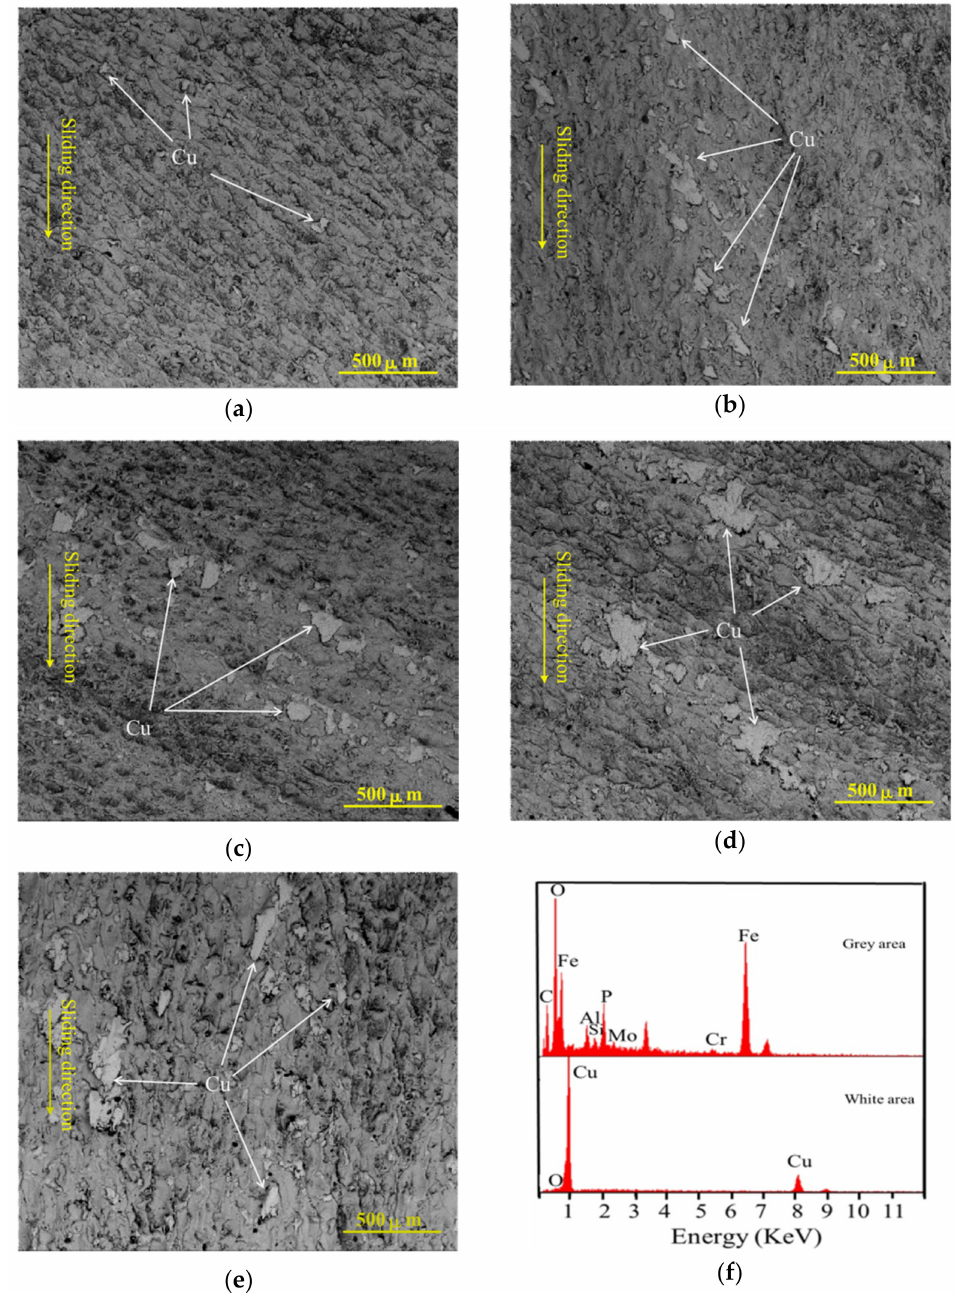
Figure 5. SEM images on the worn surfaces of 38CrMoAlA steel discs working under different loads: ( a ) 15 N; ( b ) 25 N; ( c ) 35 N; ( d ) 45 N; ( e ) 55 N. The arrows in the pictures indicate the sliding direction. ( f ) EDX analysis results on the grey area and the fillings (white